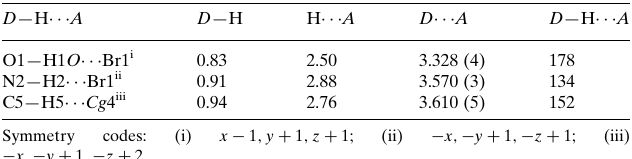
Hydrogen-bond geometry (A˚ , (cid:4) ). Cg 4 is the centroid of the C18–C23 benzene